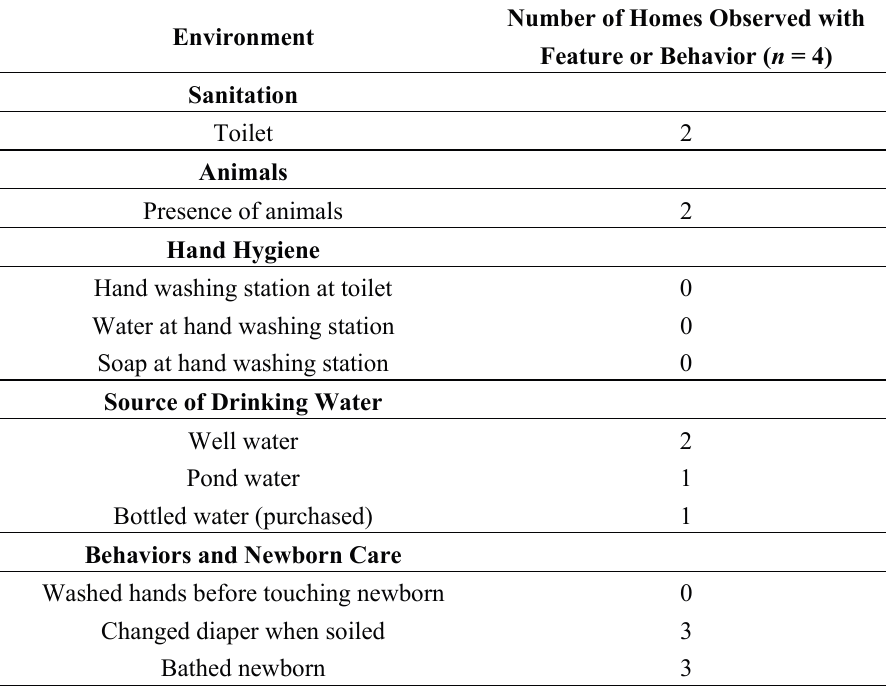
Table 4. Summary of structured home observations: environment and newborn care